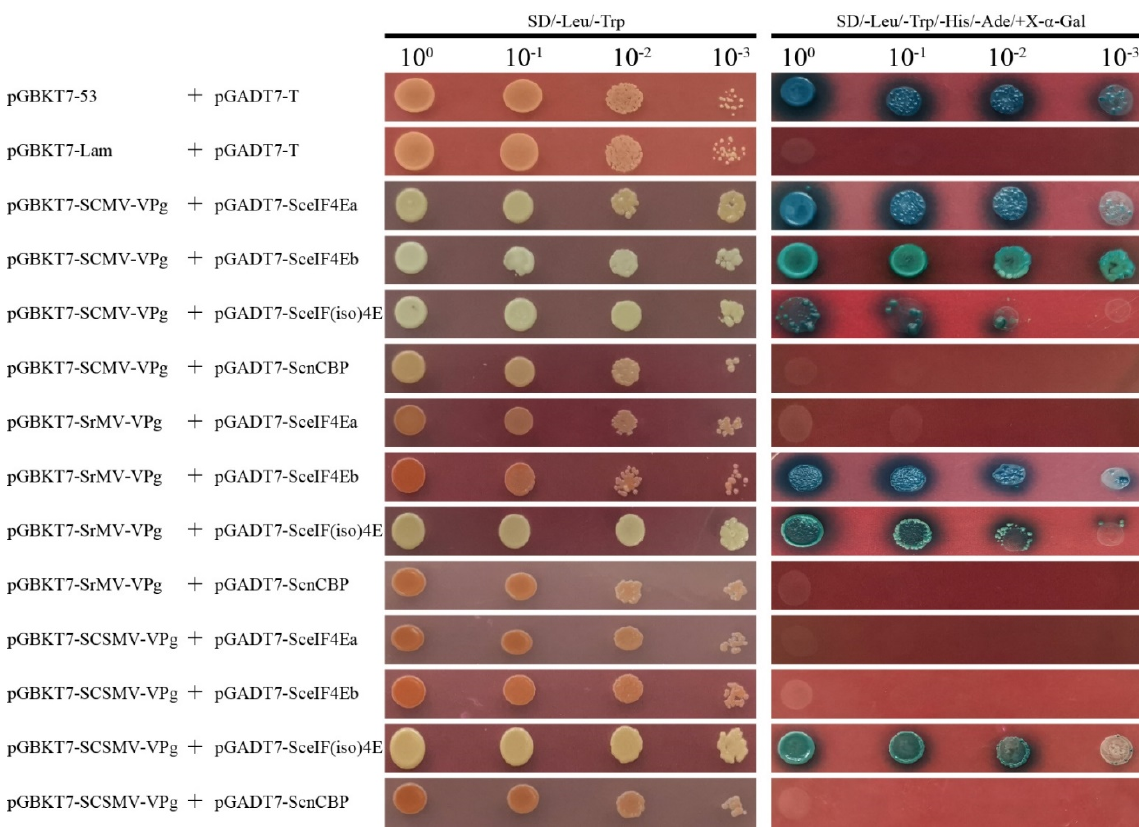
Figure 5. Investigation of protein interaction by yeast two-hybrid assays. The coding sequences of SceIF4Ea, SceIF4Eb, SceIF(iso)4E, and ScnCBP were individually infused into the prey vector pGADT7 and pairwise co-transformed with the vector pGBKT7-SCMV-VPg, pGBKT7-SrMV-VPg, pGBKT7-SCSMV-VPg into the yeast AH109 cells in a 10× dilution series of 10- μ L aliquots, which were then plated on a non-selective medium SD/-Leu/-Trp or quadruple dropout medium SD/-Leu/-Trp/-His/-Ade supplemented with X- α -Gal. Yeast cells co-transformed with pGBKT7-53 and pGADT7-T were used as a positive control, pGBKT7-Lam and pGADT7-T were used as a negative control.